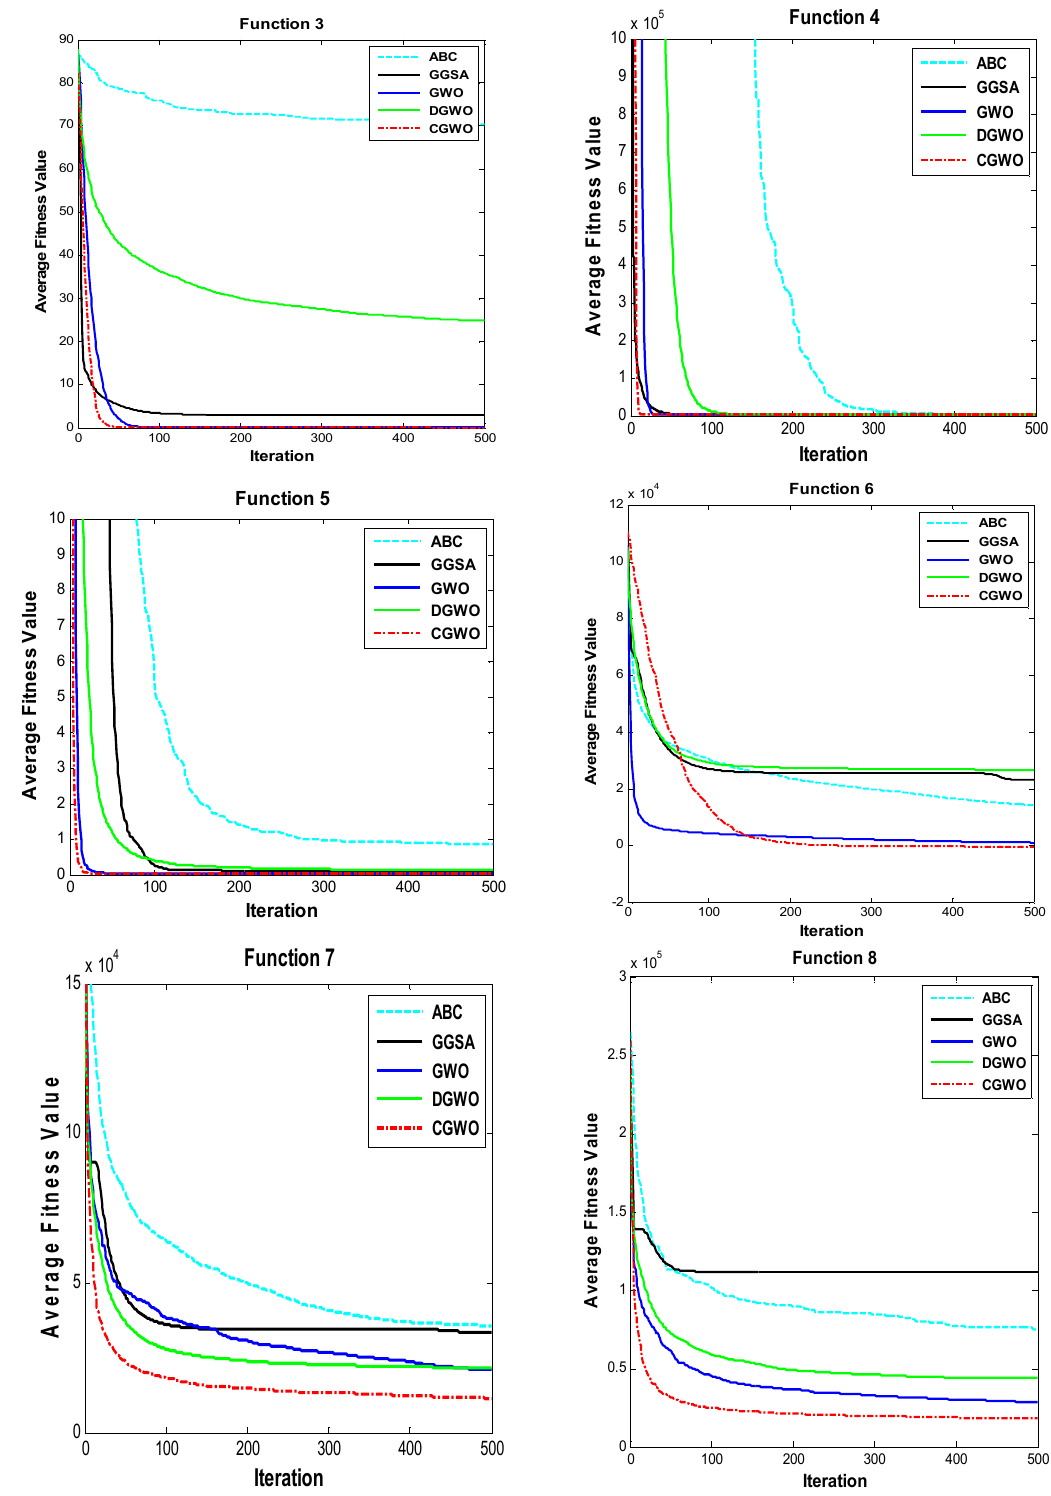
Figure 1. Convergence behavior of ABC, GGSA, GWO, DGWO, and CGWO on unimodal functions with Dim = 30.